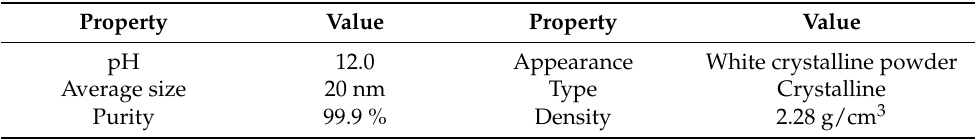
Table 2. Properties of NS. Table 1. Chemical composition of fly ash.